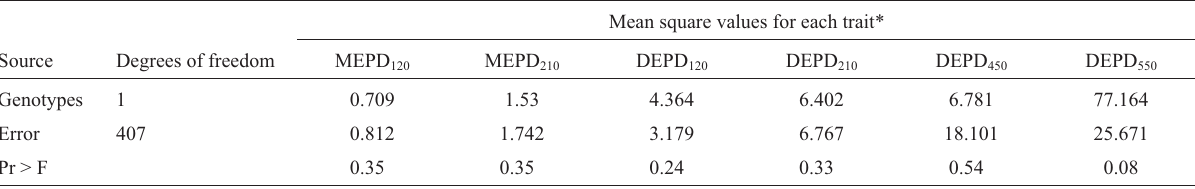
Table 2 - Analysis of variance mean square data and probability of significance between expected progeny difference (EPD) values for AA and AB k-casein CSN3 ( Hinf I) genotypes of a sample of 408 Brazilian Nellore cattle. Mean square values for each